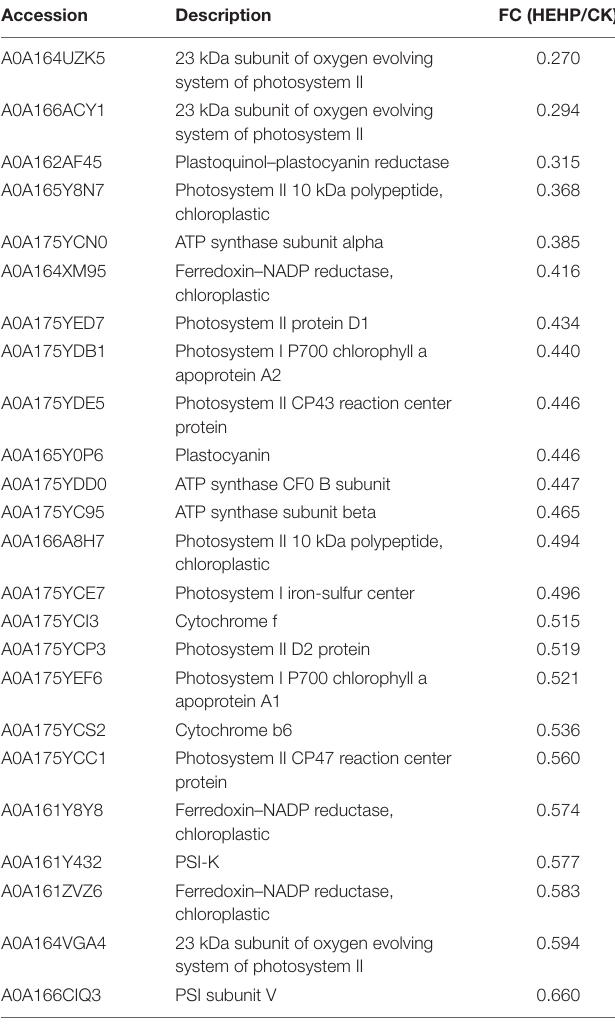
TABLE 4 | Downregulated DAPs involved in photosynthesis (pathway ID: map00195) in HEHP vs. CK.